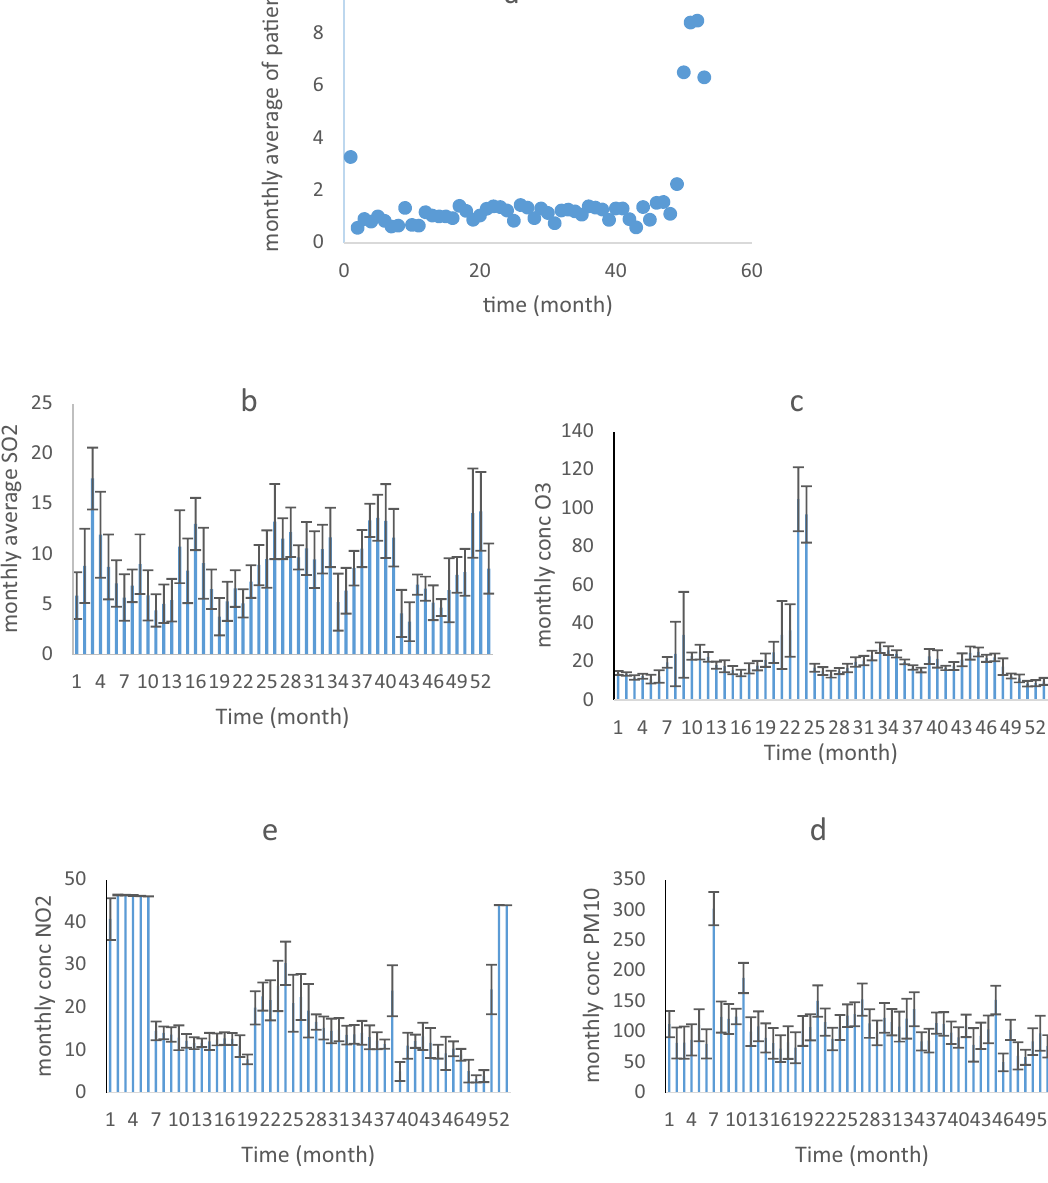
Figure 3. The monthly trend of standard pollutant concentrations and the number of CD hospital admissions.